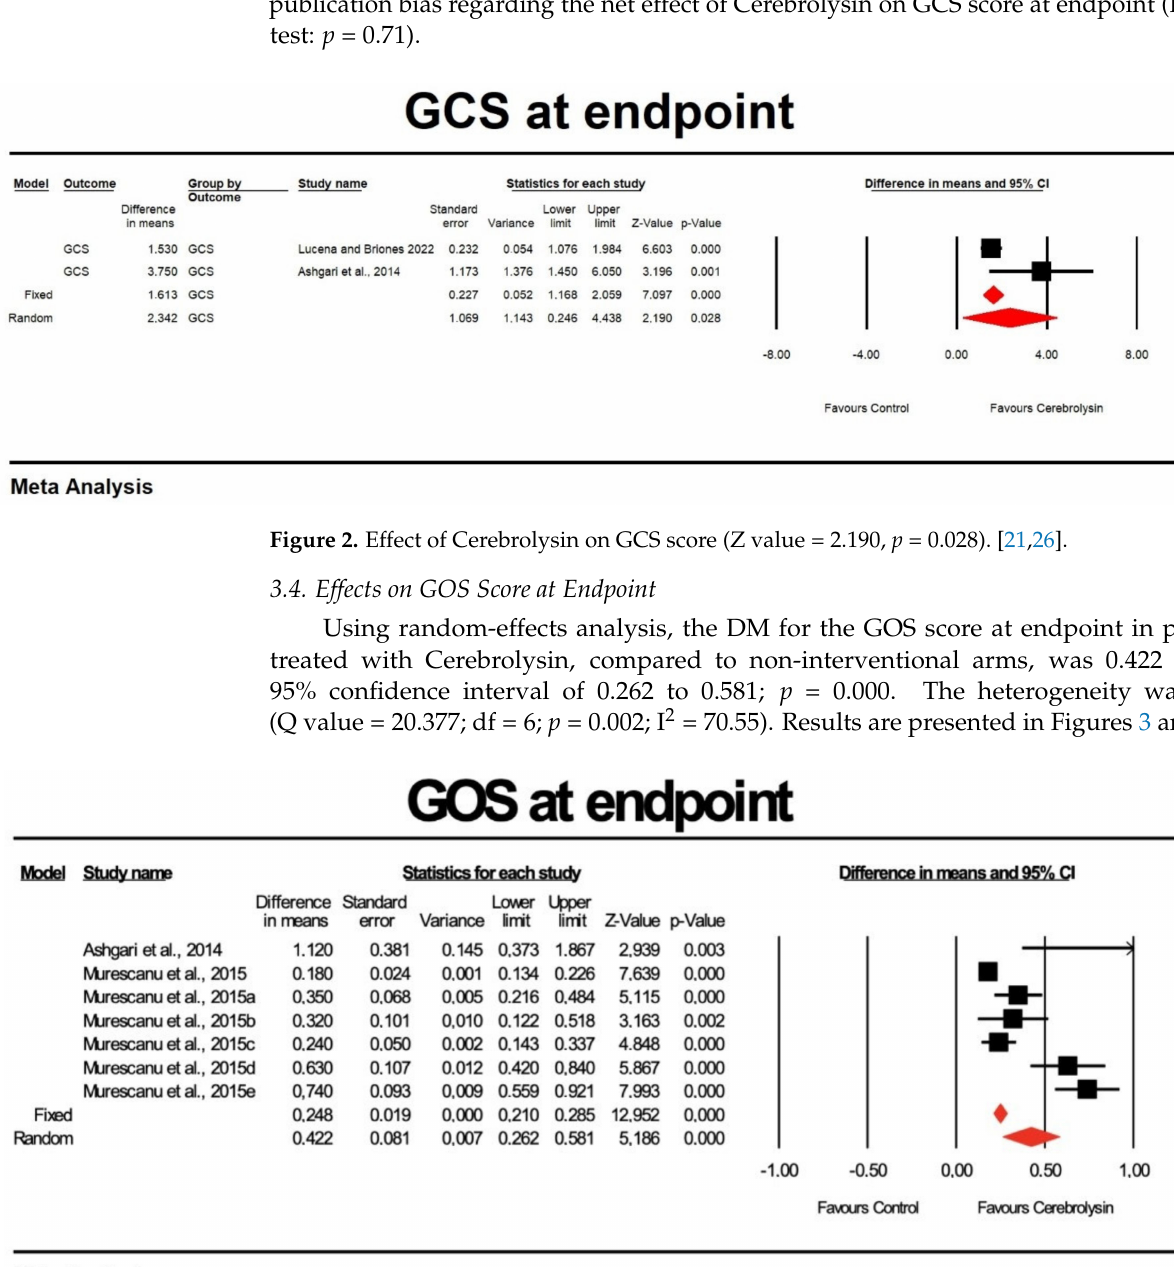
Figure 3. Effect of Cerebrolysin on GOS score (Z value = 12.962, p < 0.05).